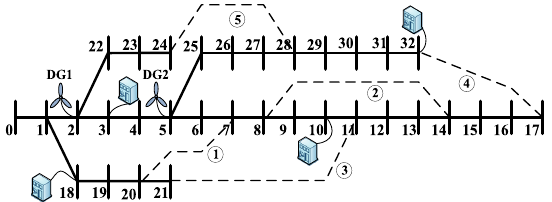
Fig. 5 IEEE 33-node system